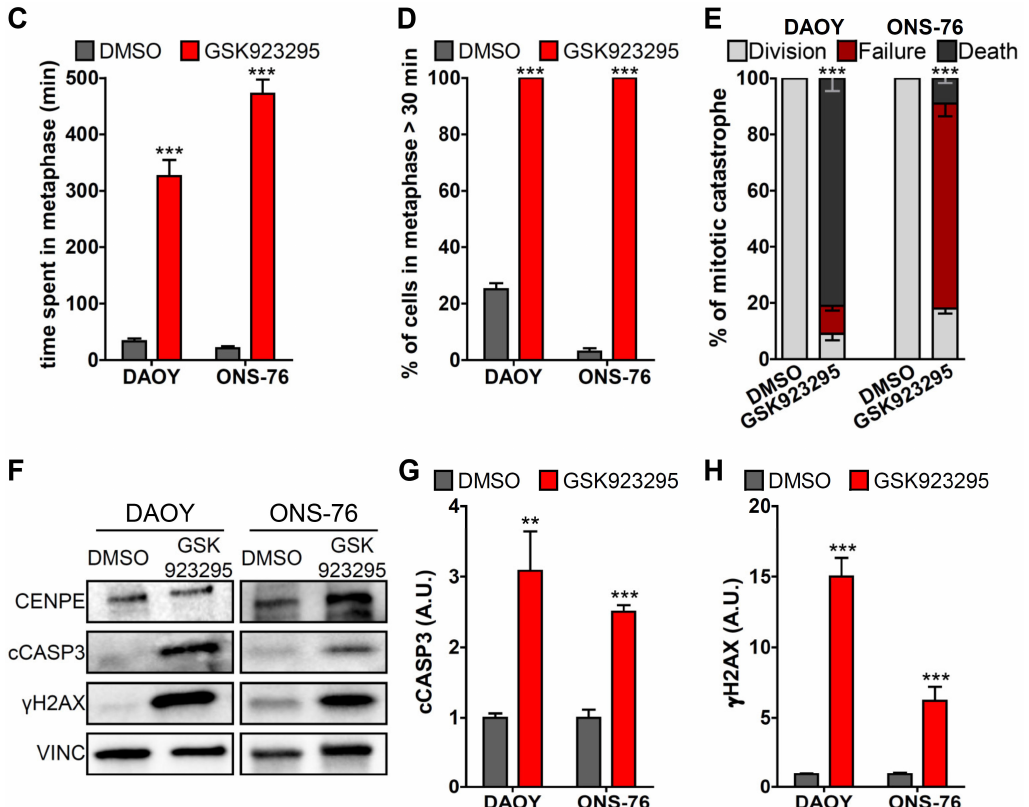
Figure 6. CENPE inhibition alters mitotic spindle assembly and induces mitotic catastrophe. ( A ) Representative images of DAOY cells, processed for immunofluorescence 24 h after treatment with DMSO or 25 nM GSK923295, immunostained with anti-CENPE and anti-Tubulin antibodies and counterstained with DAPI. ( B ) Representative frames of live-imaging experiments, performed on DAOY cells 24 h after treatment with DMSO or 25 nM GSK923295. Time lapses were recorded overnight with an interval of 5 min. ( C ) Quantification of the time spent in metaphase, in DAOY and ONS-76 cells analyzed as described in panel B. Statistical test = two-tailed Student t test. ( D ) Quantification of the percentage of metaphases lasting more than 30 min, in DAOY and ONS-76 cells analyzed as described in panel B. Statistical test = Chi 2 , considering absolute number of cells in experiments ( E ) Quantification of the percentage of correct cell division (Division), cytokinesis failure (Failure) and mitotic catastrophe (Death) in DAOY and ONS-76 cells analyzed as described in panel B. Statistical test = Chi 2 , considering absolute number of cells in experiments ( F ) Western blot analysis of total lysates from DAOY and ONS-75 cells, 24 h after treatment with DMSO or 25 nM GSK923295. The levels of CENPE, cleaved Caspase 3 (cCASP3) and γ H2AX were analyzed and the internal loading control was vinculin (VINC). The original images are shown in the Figures S1 and S2 ( G , H ) Quantification of the relative density of cCASP3 ( G ) and γ H2AX (H) in DAOY and ONS-76 cells treated as described in panel A. Statistical test = two-tailed Student t -test. All quantifications were based on at least three independent biological replicates. At least 60 cell divisions were recorded for any biological replicate. Error bars, SEM; **, p < 0.01; ***, p < 0.001. Scale bars, 5 µ